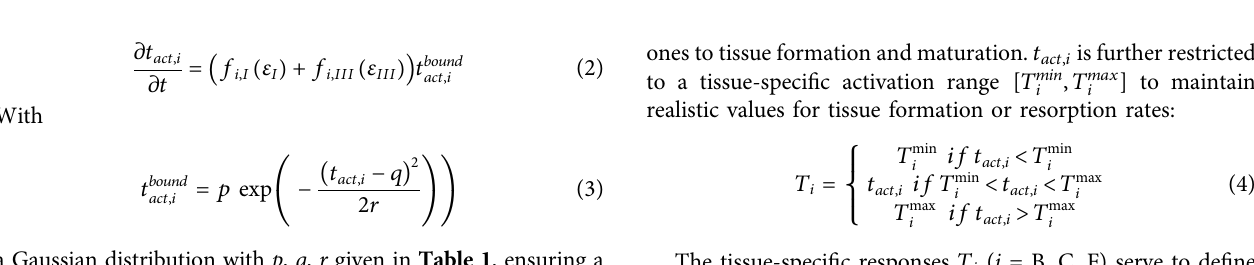
Frontiers in Bioengineering and Biotechnology |